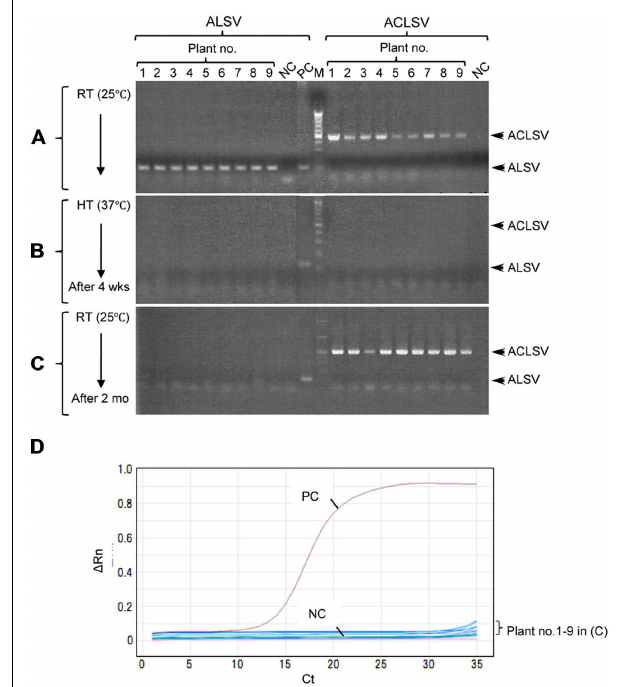
FIGURE 3 | RT-PCR detection of ALSV and ACLSV from apple seedlings before and after high-temperature treatment. (A–C) Detection of ALSV and ACLSV from apple seedlings grown at 25 ◦ C (A) , then grown at 37 ◦ C for 4 weeks (wks; B ), and transferred to 25 ◦ C and grown for 2 months (mo; plant nos. 1–9) in (C) . (D) Quantitative RT-PCR of ALSV from apple seedlings (plant nos. 1–9) in (C)